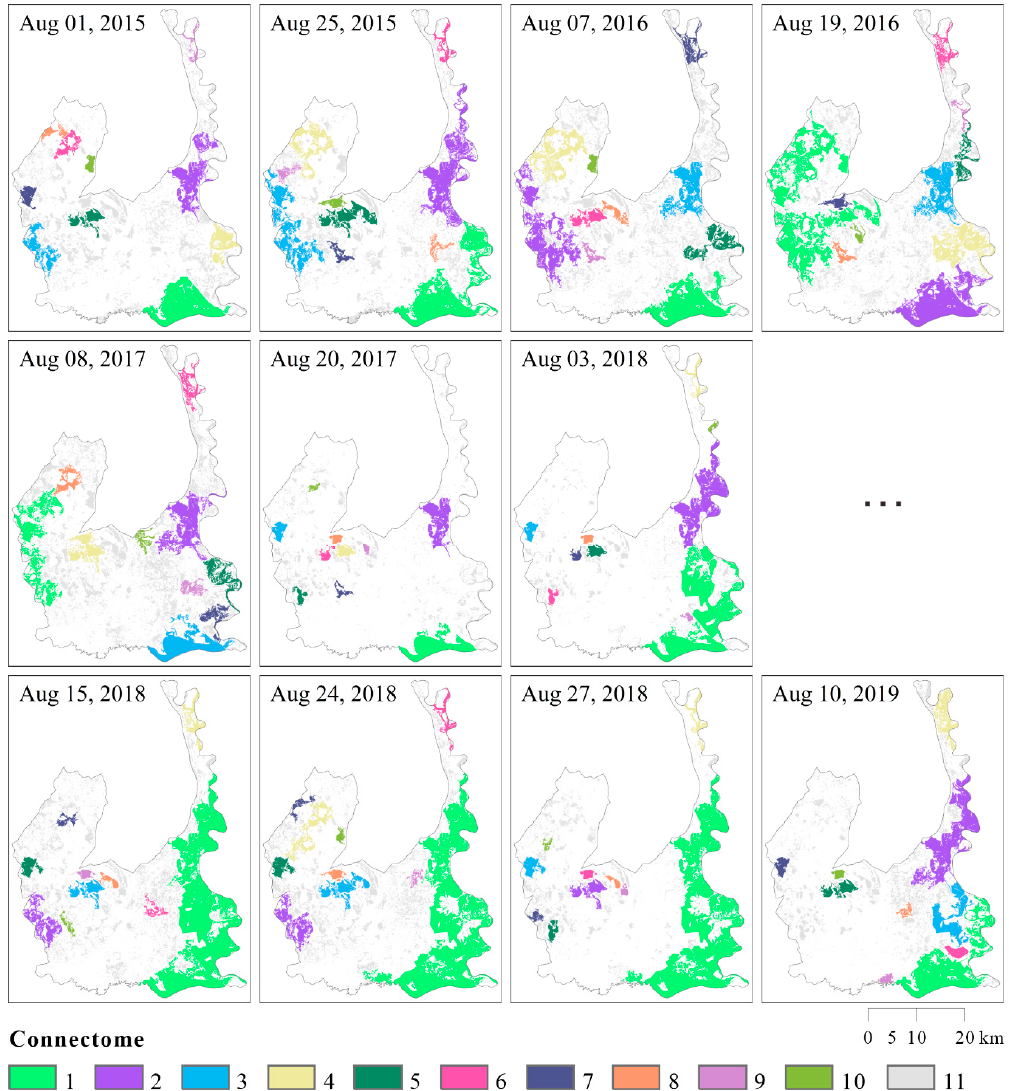
Figure 12. Spatial distribution of the connectomes (i.e., seasonally connected water bodies) in China’s Momoge National Nature Reserve in August. Colors 1 to 10 in the legend refer to the top ten largest connectomes, and color 11 refer to the remaining connectomes and isolated water bodies.